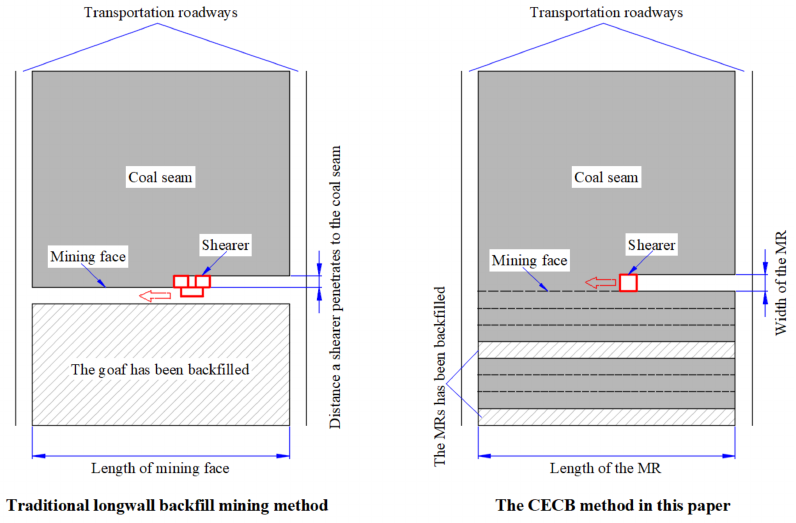
Figure 1. The comparison between traditional longwall backfill mining method and the continuous excavation and continuous backfill (CECB)